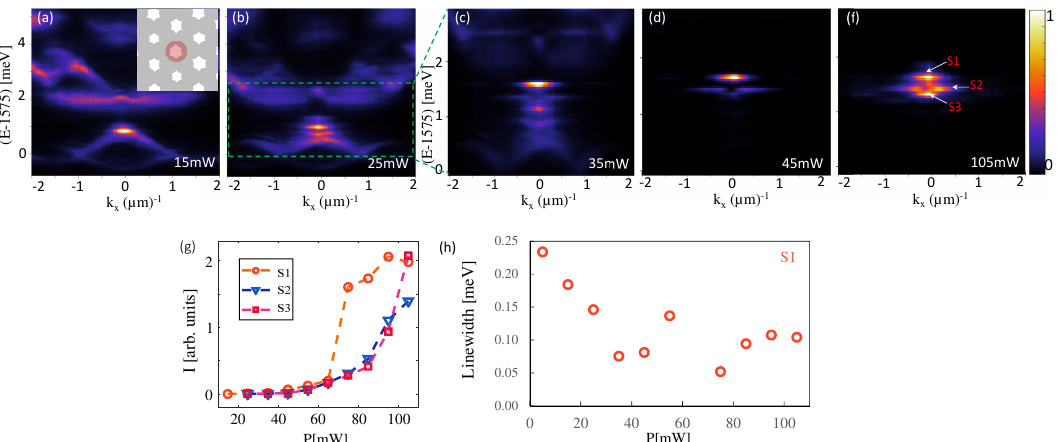
Figure 3: (a)-(f) Momentum-space emission as a function of power for an excitation spot centred on one of the hexagons of the lattice, as sketched with a red circle in the inset of (a). For each image, the linear colour scale has been normalised to the maximum intensity. (g) Measured emission intensity as a function of excitation power for the three lasing gap modes. (h) Measured linewidth (full width at half maximum) of the S1 gap state extracted from a Gaussian fit to its spectral profile.